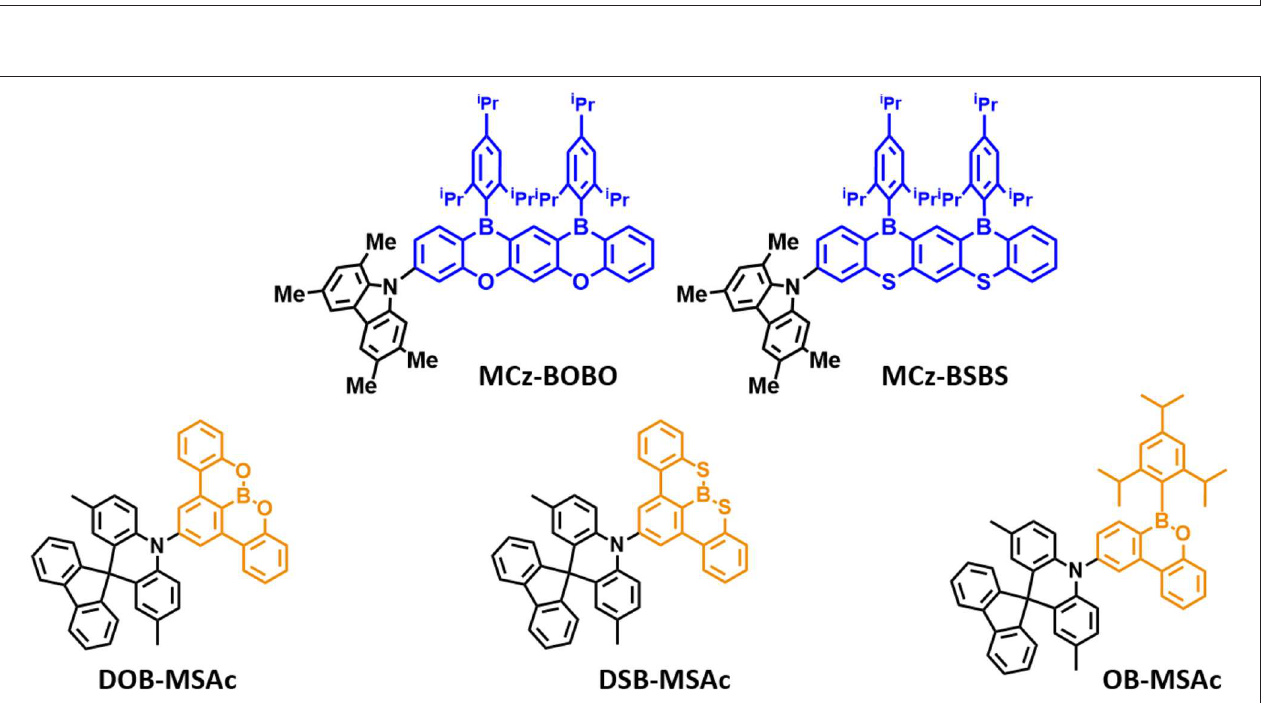
FIGURE 4 | Reported partially bridged boron acceptor for blue thermally activated delayed fluorescence (TADF) emitters. In these molecules, the acceptor is highlighted in blue and yellow color.